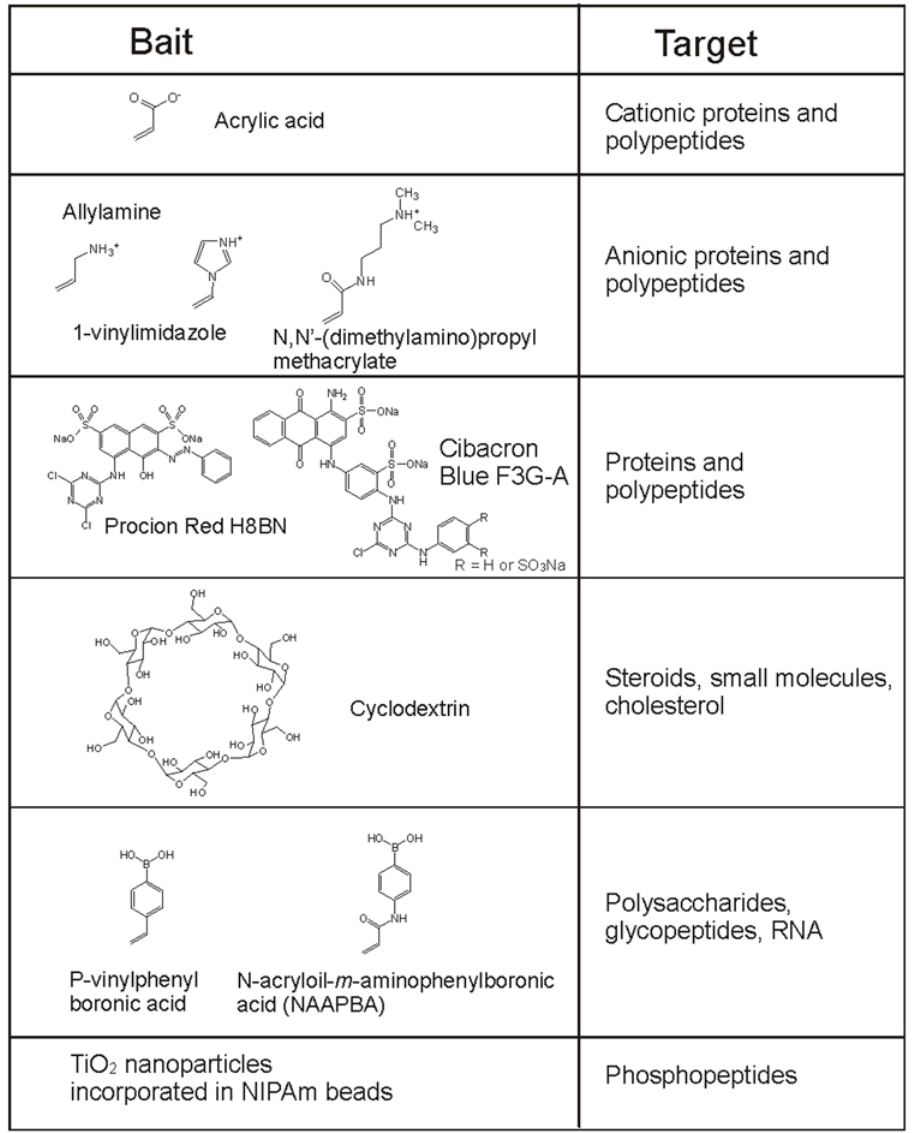
Figure 1. Bait chemistry.